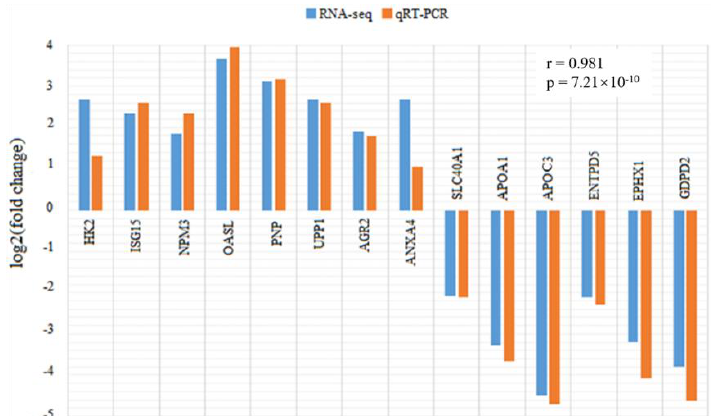
Figure 3. Comparison of expression fold changes in 14 differential expression genes ( HK2 , ISG15 , NPM3 , OASL , PNP , UPP1 , AGR2 , ANXA4 , SLC40A1 , APOA1 , APOC3 , ENTPD5 , EPHX1 , and GDPD2 ) between RNA-seq and qRT-PCR data. Fold changes are expressed as the ratio of gene expression levels in PEDV-infected and control groups. The blue and orange bars indicate the RNA-seq and qRT-PCR data, respectively. HK2 : hexokinase 2; ISG15 : ISG15 ubiquitin like modifier; NPM3 : nucleophosmin/nucleoplasmin 3; OASL : 2'-5'-oligoadenylate synthetase like; PNP : purine nucleoside phosphorylase; UPP1 : uridine phosphorylase 1; AGR2 : anterior gradient 2; ANXA4 : annexin A4; SLC40A1 : solute carrier family 40 member 1; APOA1 : apolipoprotein A1; APOC3 : apolipoprotein C3; ENTPD5 : ectonucleoside triphosphate diphosphohydrolase 5; EPHX1 : epoxide hydrolase 1; GDPD2 : glycerophosphodiester phosphodiesterase domain containing